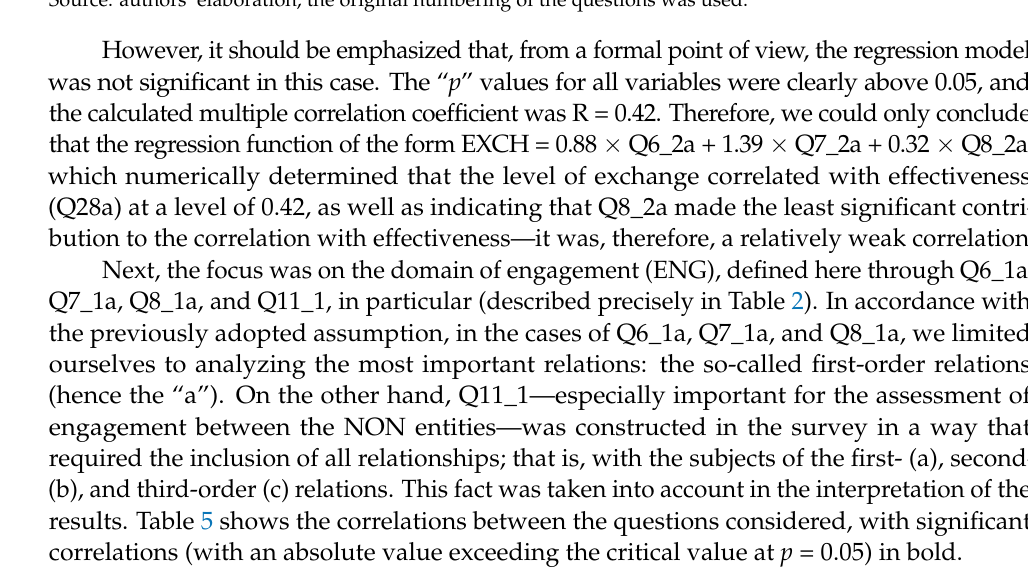
Table 5. Spearman rank correlation coefficients for Q6_1a, Q7_1a, Q8_1a, and